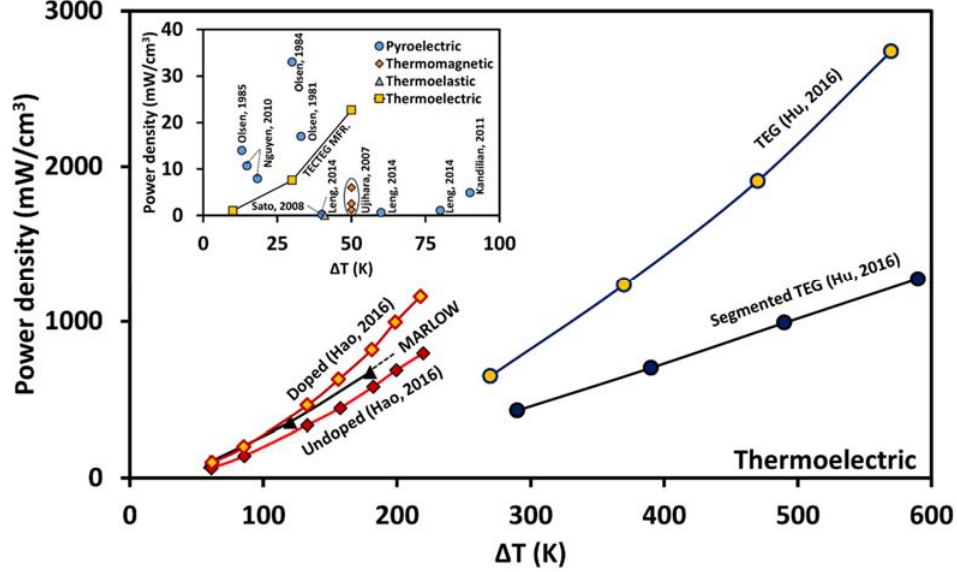
Figure 27. Power density (mW/cm 3 ) demonstrated by working prototypes/devices based various thermal energy harvesting technologies. Data are compiled from numerous papers published in the literature and datasheet of commercial products. References: Thermoelectric (TEG2-126LDT, TECTEG MFR. [221]; TG12-2.5-01LS, MARLOW [90]; Undoped and doped BiTe based TEG, Hao et al. 2016 [88]; Non-segmented and segmented nanostructured PbTe based TEG, Hu et al. 2016 [89]), Pyroelectric (PZST based PEG, Oslen et al. 1985 [117]; PZST based regenerative PEG, Oslen et al. 1981 [129]; PZST bases cascaded PEG, Oslen et al. 1984 [128]; P(VDF-TrFE) based PEG, Nguyen et al. 2010 [134]; PVDF film based PEG, Leng et al. 2014 [138]; PMN–32PT single crystal based PEG, Kandilian et al. 2011 [131]), Thermomagnetic (Gadolinium based thermomagnetic harvester, Ujihara et al. 2007 [179]), Thermoelastic (Shape memory alloy heat engine, Sato et al. 2008 [220]).